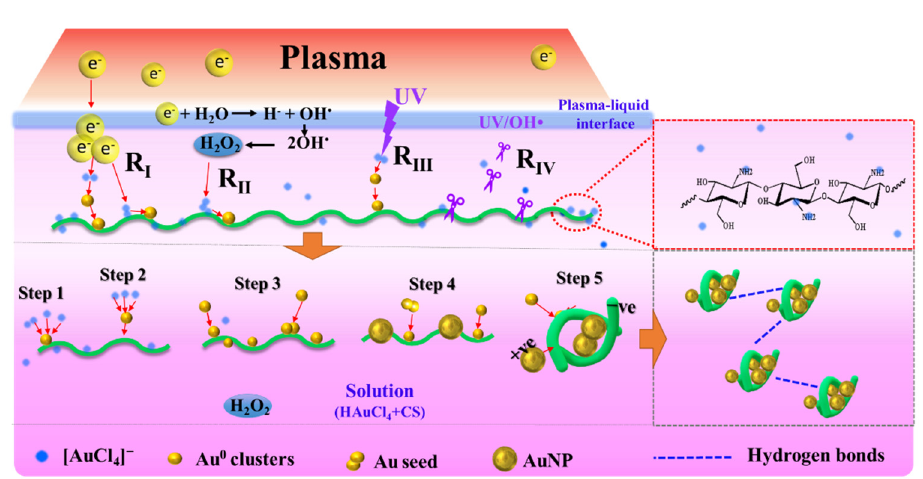
Figure 4. Zeta potential of samples under investigation: ( a ) Au, 2.5 µM AuNP/m-CS, 0.1 mM AuNP/m-CS, 0.2 mM AuNP/m-CS, 0.5 mM AuNP/m-CS, 1.0 mM AuNP/m-CS, 2.0 mM AuNP/m- CS, 4.0 mM AuNP/m-CS, ( b ) l-CS, m-CS, h-CS, 0.5 mM AuNP/l-CS, 0.5 mM AuNP/m-CS, 0.5